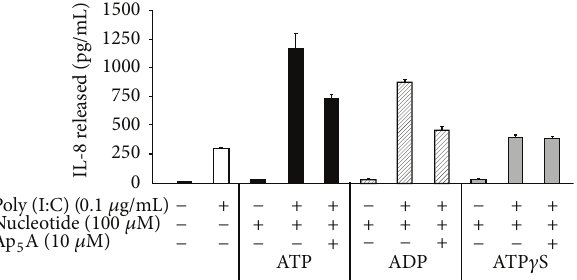
Figure 3: NTPDase2 and ADK modulate IL-8 production in HT- 29 cells. HT-29 cells were stimulated for 18h with suboptimal concentration of poly (I:C) in combination with ATP, ADP, or the nonhydrolyzable ATP analog, ATP- 𝛾 -S, in the presence or absenceoftheADKinhibitor,Ap 5 A.Thecellsupernatantswerethen analyzed for IL-8 by ELISA ( 𝑛 = 3 ).